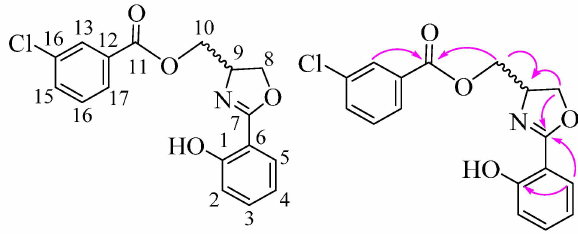
Figure 2. The main HMBC of compound 5n . Table 3. HMBC data of compound 5n